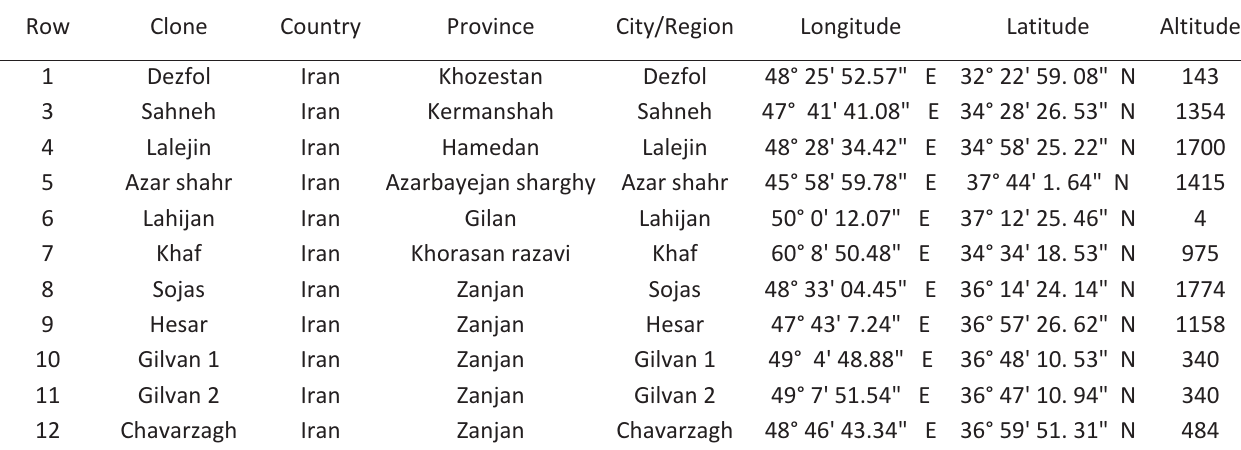
Table 1 ­ Origin specifications of Iranian garlic clones Row